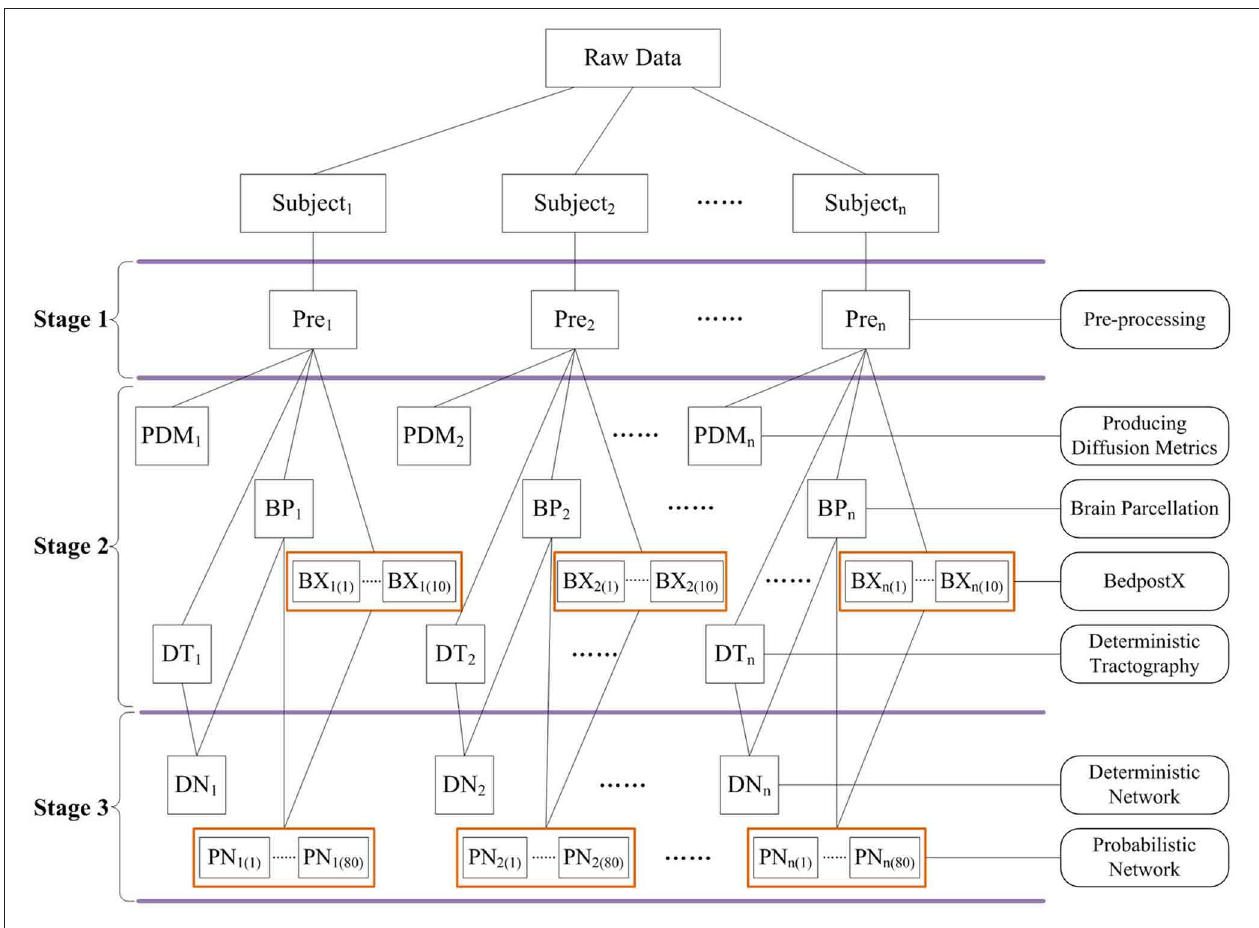
Stage 2 and Stage 3 can be parallelized as well. In addition, BedpostX and Probabilistic Network Construction have been internally parallelized, as indicated by orange